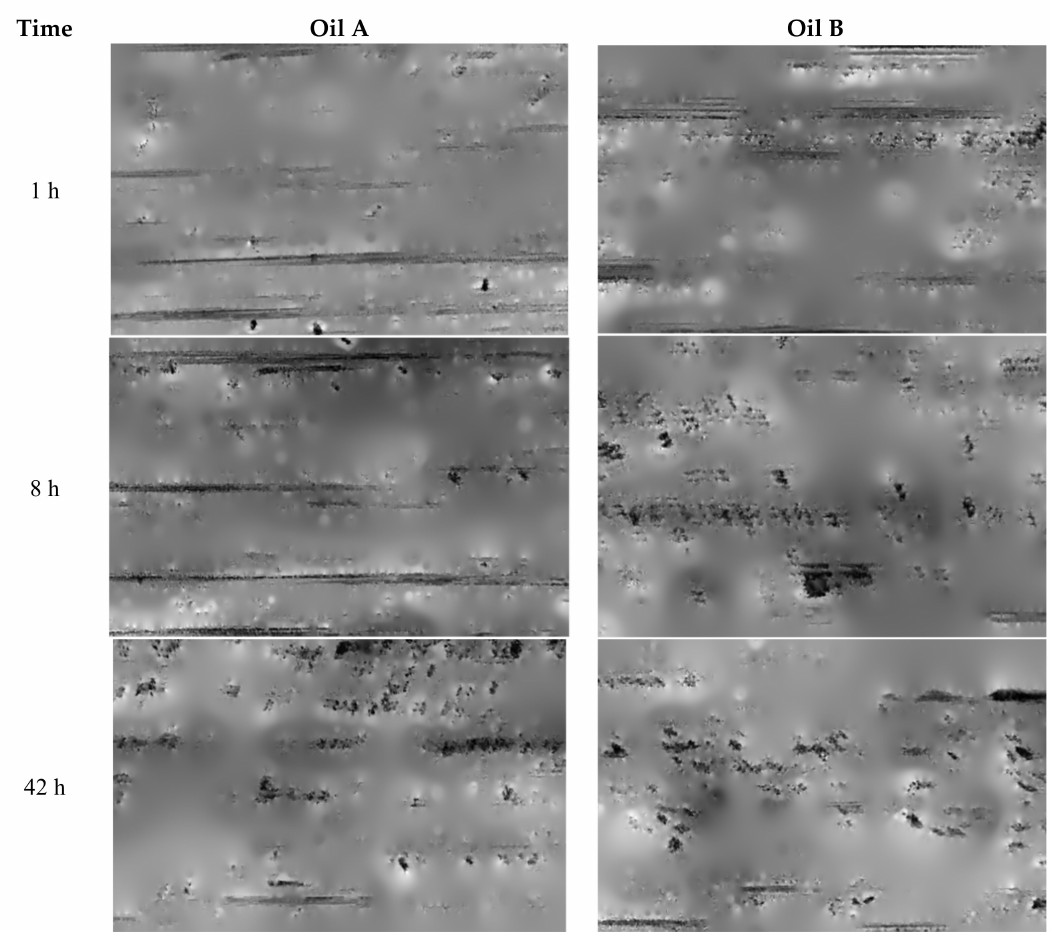
Figure 20. Evolution during wear of the reconstructed surfaces representing the relevance of the roughness